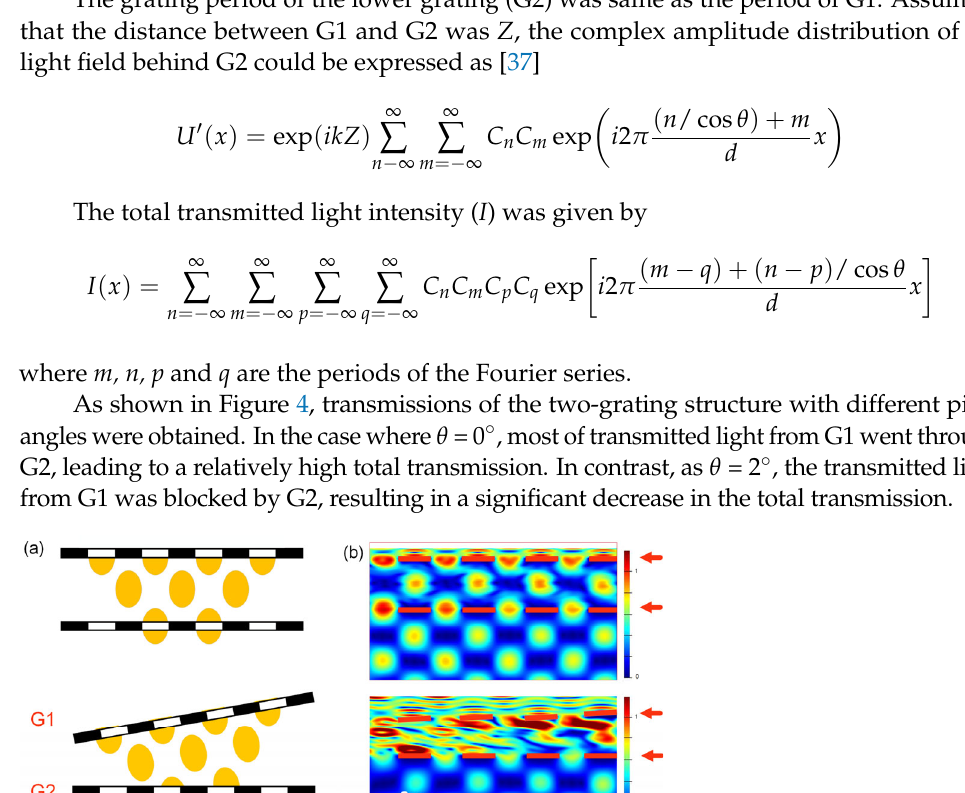
Figure 3. The relationship between the pitch angle and the shift of the Talbot image. The black dots indicate the simulated value of the transversal shift of the Talbot image. The red line indicates the linear fitting straight line (R 2 > 99%). In the simulation, the number of grating lines was 10 and the distance from the center of the Talbot image to G1 was L 1 = 4 μ m.